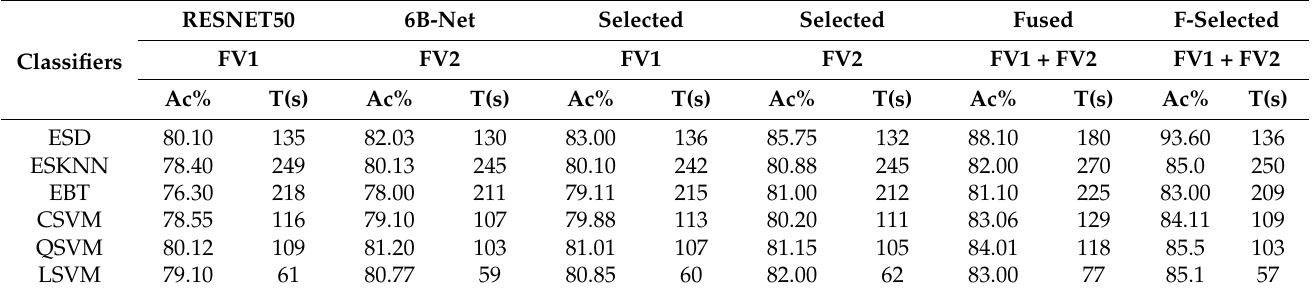
Table 5. Results using proposed feature fusion and selection-based method on breast cancer pathology dataset with four classes and five-fold validation, where Ac% represents the accuracy in percent, and T(S) represents the training time in